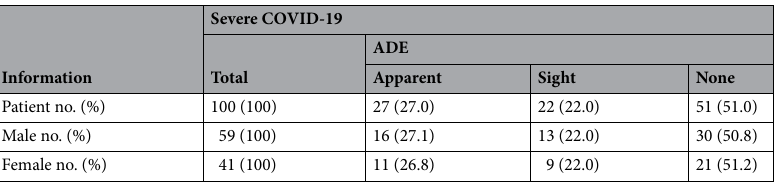
Table 1. ADE activity in sera from severe COVID-19 patients. Information about ADE activity in each serum sample is derived from Fig. 3a and Supplemental Fig. S9. The numbers and percentages in each category are indicated.